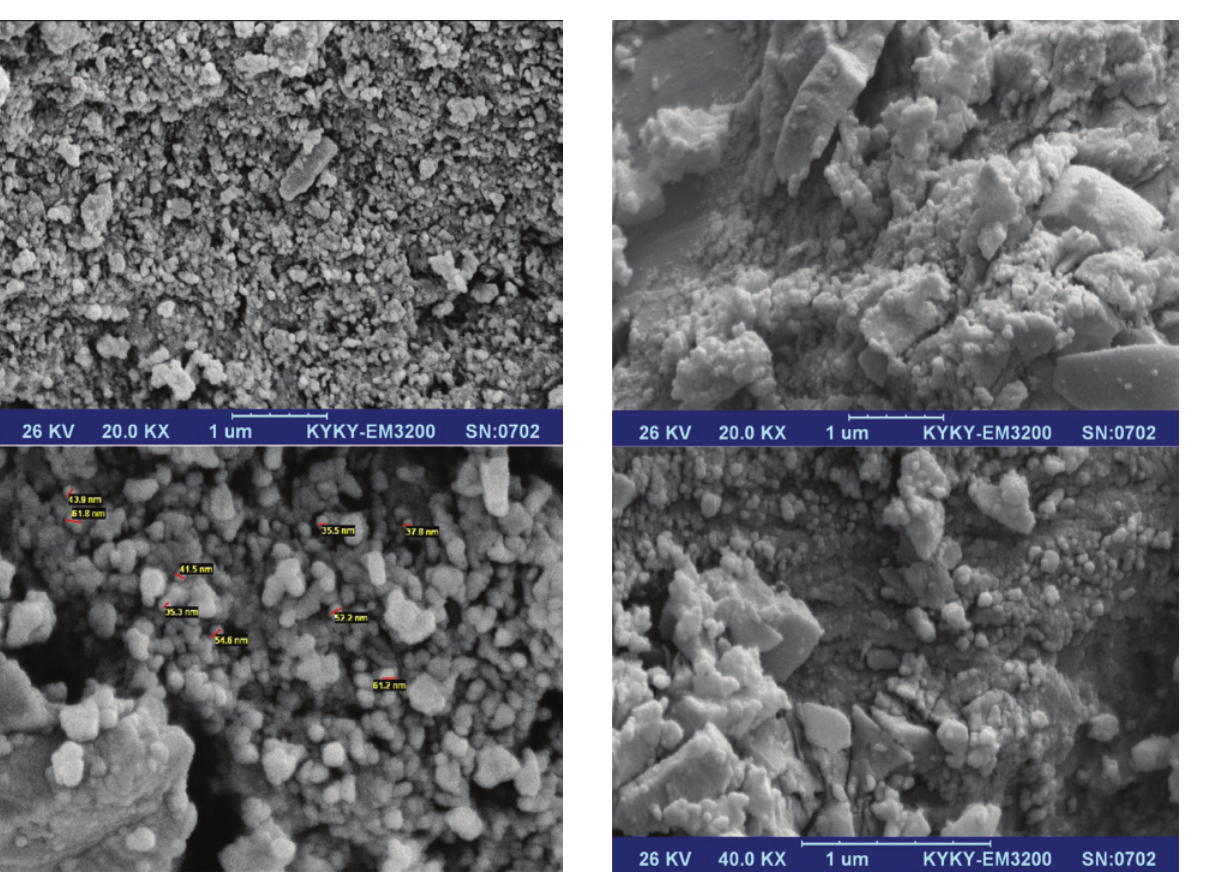
Figure 5: The SEM images of the PbFe synthesized with salicylic acid.